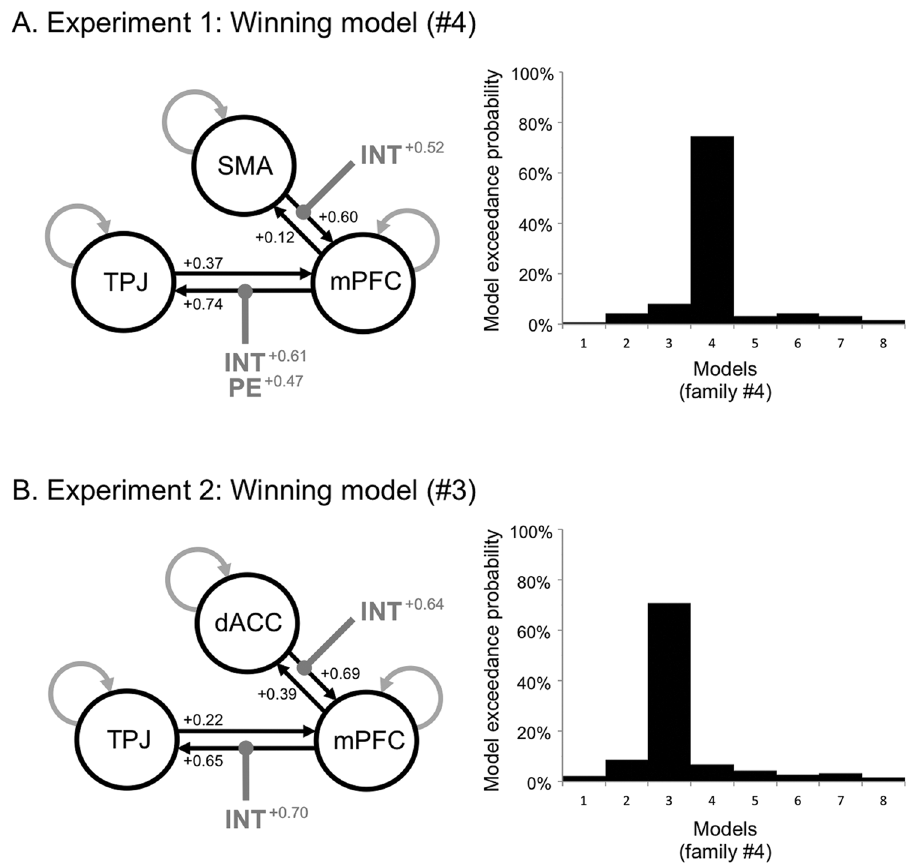
Figure 7. Dynamic causal modeling of connectivity between preparation and inference regions. The first eigenvariate of BOLD from SMA (Experiment 1) or dACC (Experiment 2), mPFC and TPJ clusters, was extracted at subject-specific coordinates within 8-mm spheres around individually defined activation maxima. For the winning family (not shown here, see Supplementary Information, Figure S4), eight models tested whether the intention type (INT) modulated the forward connection between preparation (SMA or dACC) and mPFC regions, and whether the intention type (INT) or participant’s priors (PE), or both, modulated the forward or the backward connections between mPFC and TPJ (see ‘DCM analysis procedure’). In all models, there were bilateral intrinsic connections between preparation and mPFC regions, and between mPFC and TPJ regions. Bayesian model comparison was used to compute the exceedance probability for each of the eight models. All connections and their values are shown for the best-fitting model. A: Basic vs. Superordinate intentions (Experiment 1). The exceedance probability was largest for model #4, where the intention type (INT) modulated the forward connection between SMA and mPFC, and where both intention type (INT) and priors (PE) modulated the backward, but not the forward, connection between mPFC and TPJ. B: Non-Social vs. Social intentions (Experiment 2). The exceedance probability was largest for model #3, where the intention type modulated the forward connection between dACC and mPFC and the backward, but not the forward, connection between mPFC and